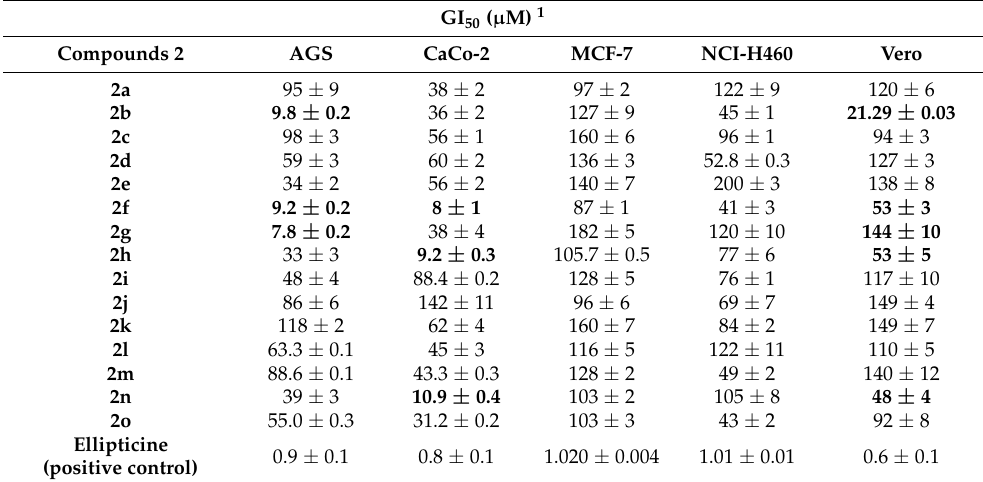
Table 2. GI 50 concentrations of compounds 2a – 2o and the positive control Ellipticine in four human tumor cell lines and in a non-tumor cell 1